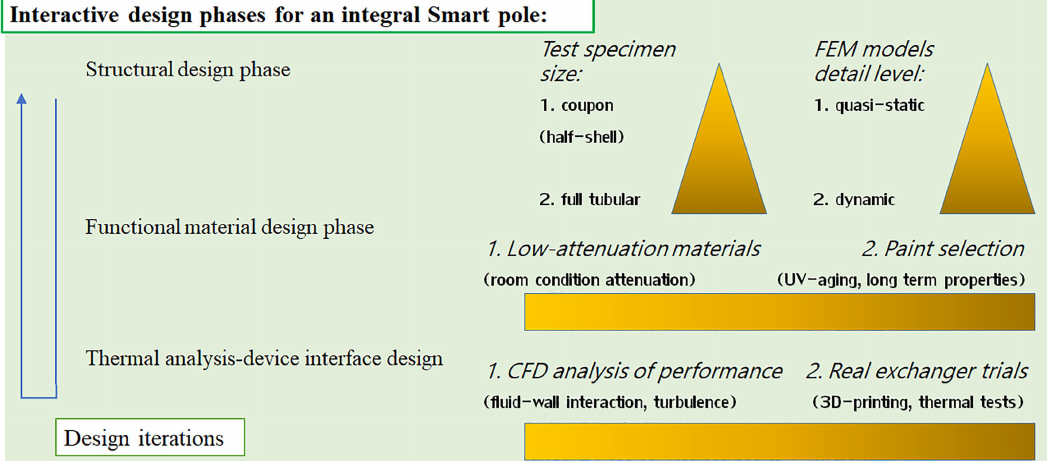
Figure 2. A graph of the main analysis phases for an integral smart pole allowing current 5G